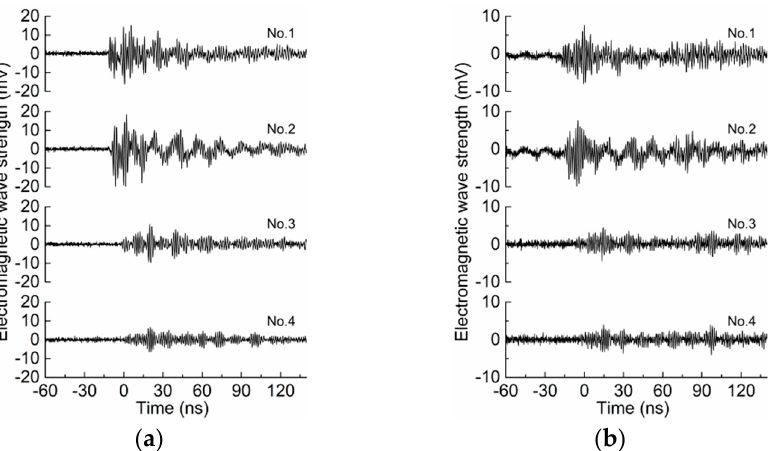
Figure 6. Time domain waveforms of UHF signals induced by protrusion defect ( θ = 0°, DS open). ( a ) U = 6.5 kV; ( b ) U = 9.6 kV.